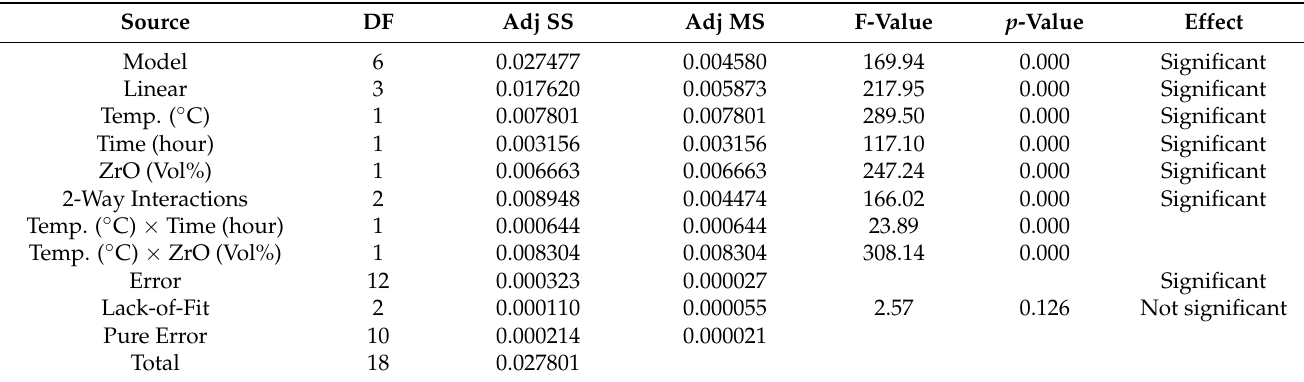
Table 8. The analysis of variance of density by full factorial.